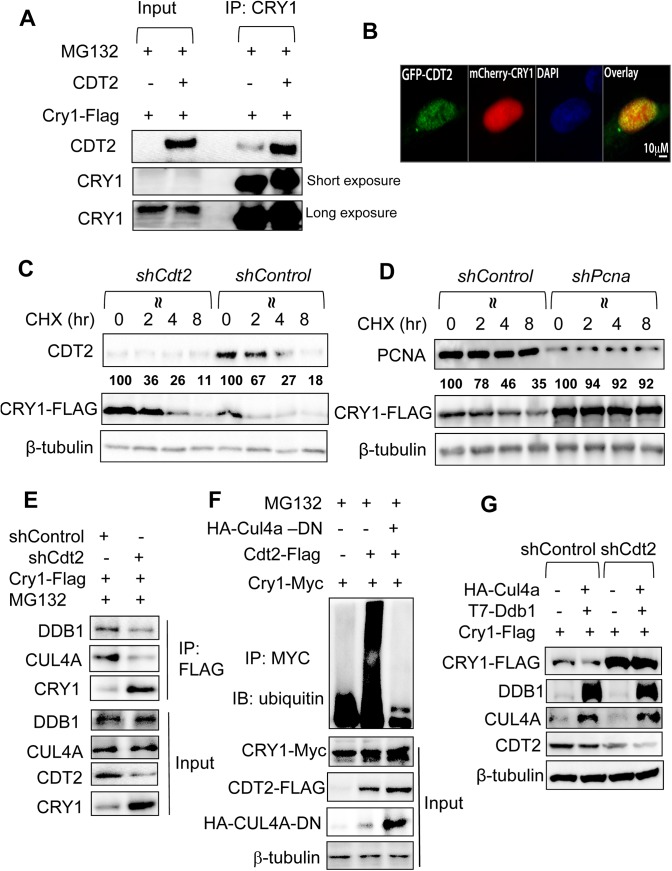
CDT2 functions as a substrate-binding protein for DDB1-CUL4A-mediated regulation of CRY1 protein.(A) CRY1 interacts with both the endogenous and overexpressed CDT2. U2OS cells were transfected with Cry1-Flag in the presence or absence of Cdt2 expression vector. Cells were treated with MG132 for 16 hr prior to IP with anti-CRY1. The presence of CDT2 was detected by anti-CDT2. (B) CRY1 and CDT2 co-localize in the nucleus. U2OS cells were transfected with both mCherry-Cry1 and GFP-Cdt2 and treated with MG132 at 10 μM for 3 hr prior to methanol fixing, Triton X-100 permeabilization, and DAPI counterstaining. mCherry-CRY1 and GFP-CDT2 fluorescent protein signals were captured by confocal imaging and overlaid by Image J software. (C) Cdt2 knockdown increases CRY1 protein stability in 293T cells. 293T cells were co-transfected with Cry1-Flag along with either control shRNA or Cdt2 shRNA for 48 hr. Cells were then treated with cycloheximide (CHX) for 0, 2, 4, and 8 hr before harvest. The expression levels of CRY1-FLAG were determined by immunoblotting and quantified. The percentage of the remaining CRY1 at each time point was calculated by comparing to the CRY1 abundance at time 0 hr. The experiments were repeated three times and a representative one is shown here. (D) Effect of knockdown of CDT2 co-factor Pcna on the CRY1 protein degradation. 293T cells were co-transfected with CRY1-Flag along with either shControl or shPcna vector. 48 h later, Cells were treated with CHX at 10 μg/mL for the indicated times prior to immunoblotting. The percentage of the remaining CRY1 at each time point was calculated by comparing to the CRY1 abundance at time 0 hr. (E) Depletion of Cdt2 reduces CRY1 interaction with DDB1-CUL4A complex. U2OS cells were transfected with CRY1-Flag together with either shControl or shCdt2 vectors. 48 hr later, cells were exposed to MG132 for 8 hr before harvest. The interaction between CRY1-FLAG and the endogenous DDB1-CUL4A complex was examined by immunoprecipitation with anti-FLAG. (F) CDT2 promotes CRY1 ubiquitination via a functional CUL4A-DDB1 complex. Myc-Cry1 was co-transfected with or without Cdt2 expression vector. To block the endogenous CUL4A-DDB1 complex, HA-Cul4a-DN was co-transfected along with Cry1 and Cdt2 vector. Cells were treated with MG132 for 16 hr before detection of CRY1 ubiquitination, as described above. (G)
Cdt2 depletion blocks on DDB1-CUL4A-mediated CRY1 degradation. U2OS cells were transfected with Cry1-Flag or Cry1-Flag/T7-Ddb1/HA-Cul4a in the presence of either shControl or shCdt2 vector. Cells were then harvested 48 hr later for examining levels of CRY1-FLAG, DDB1, CUL4A, CDT2, and β-tubulin.